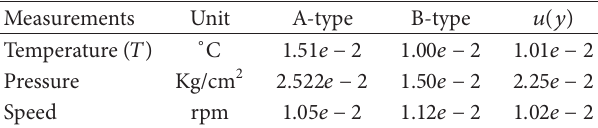
Table 2: Uncertainty estimation of variables.